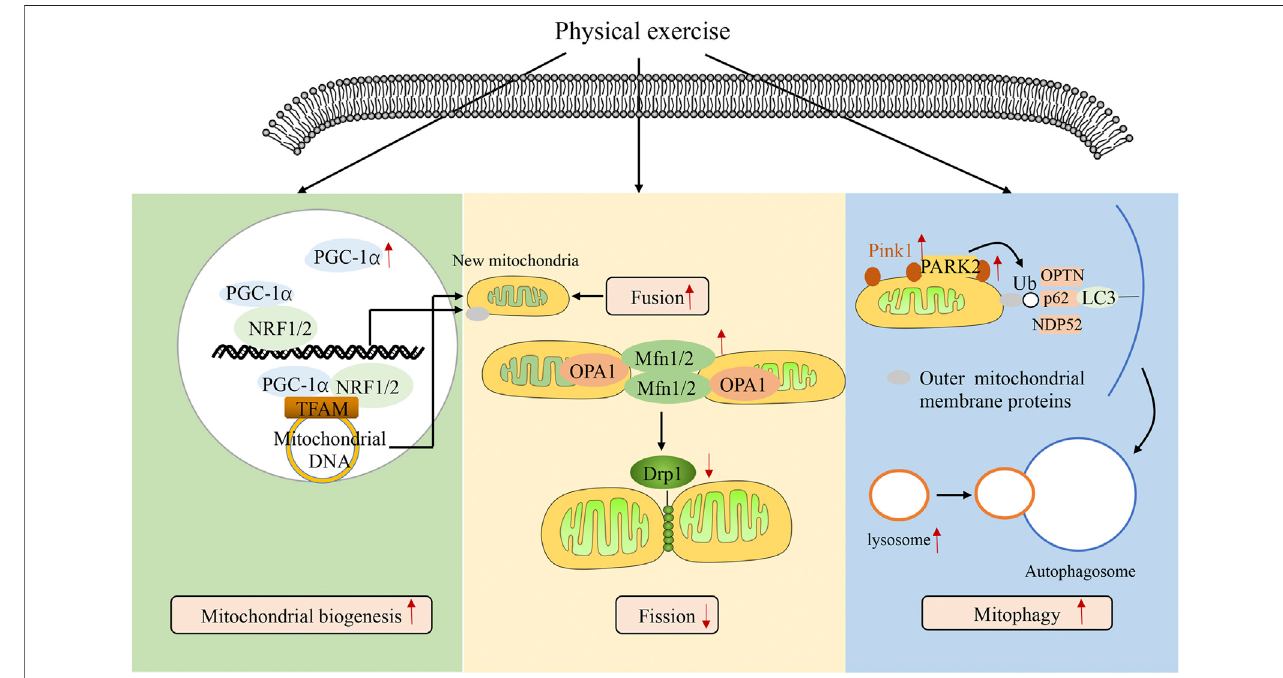
FIGURE 1 | Physical exercise regulating mitochondrial quality control. The fi gure shows how physical exercise mediates mitochondrial quality control. Mitochondrial quality is controlled by various processes, including mitochondrial biogenesis, mitochondrial fusion/ fi ssion, and mitophagy. Processes of mitochondrial biogenesis are controlled by biogenesis signals such as PGC-1 α , NRF-1, NRF-2, AMPK, SIRT1, and TFAM. PGC-1 α plays a central role in mitochondrial biogenesis, interacting with NRF-1 and NRF-2 in both the mitochondria and nucleus. In the mitochondria, PGC-1 α binds with NRF-1 and NRF-2, coactivating TFAM, which in turn mediates mitochondrial DNA translation, transcription, and replication. In the nucleus, PGC-1 α binds with NRF-1 and NRF-2, inducing the nuclear translation of mitochondrialproteins,whichareimportedintothemitochondria.Mitochondrialfusionand fi ssionaremediatedby fi ssionproteinssuchasDrp1andfusionproteinssuch as Mfn2, Mfn1, and OPA1. PINK1 import to the inner mitochondrial membrane is inhibited when it detects a damaged mitochondrion, resulting in the accumulation of PINK1 on the outer mitochondrial membrane. PINK1 phosphorylates ubiquitin, a substrate of PINK1, which then induces the recruitment of Parkin to the damaged mitochondria. Then, PARK2 is phosphorylated and binds to outer mitochondrial membrane proteins and autophagy adaptor proteins, ultimately resulting in mitophagy. Physical exercise promotes mitochondrial quality control.